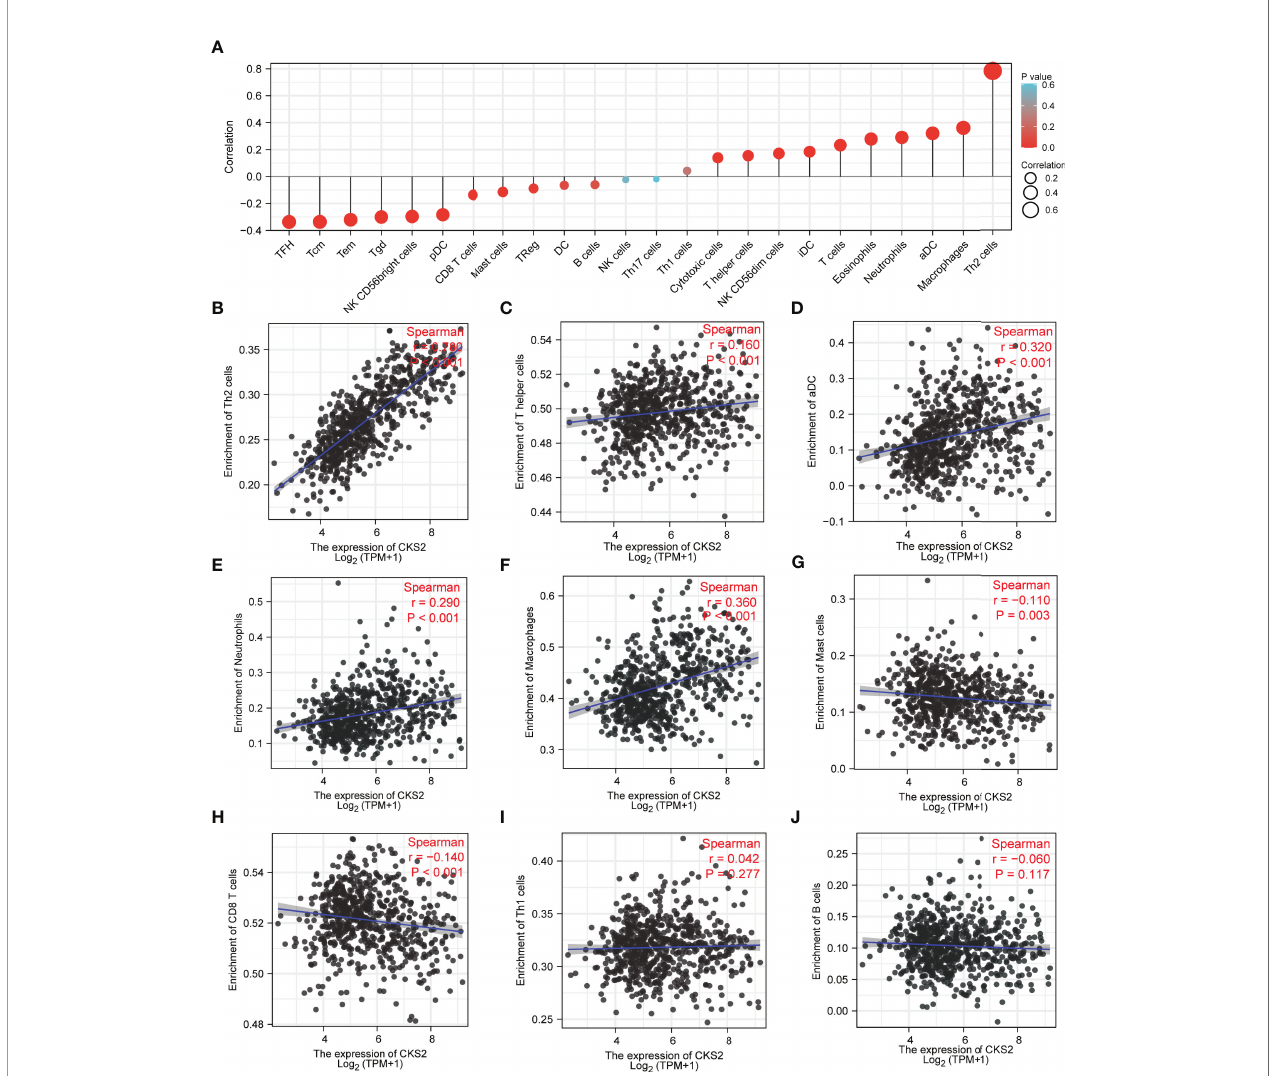
FIGURE 7 | ssGSEA investigation of CKS2 in glioma and correlation between CKS2 expression and immune cell in fi ltration class. (A) Correlation between immune cell in fi ltration and CKS2 expression. (B – F) CKS2 expression and Th2 cells (B) and T helper cells (Th) (C) . In fi ltration levels of activated dendritic cells (D) , neutrophils (E) , and macrophages (F) were positively correlated. (G, H) CKS2 expression correlated with the in fi ltration of mast cells (G) and CD8 + T cells (H) In fi ltration levels were negatively correlated. (I, J) CKS2 expression was not associated with in fi ltration levels of Th1 cells (I) and B cells (J)